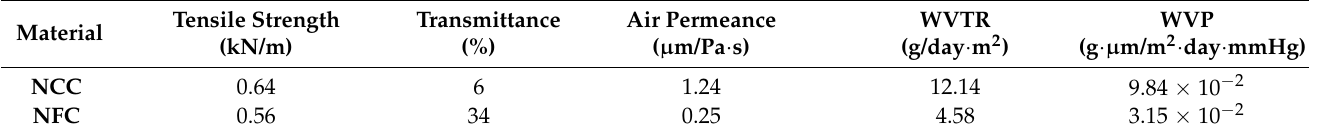
Table 4. Tensile strength, transparency, air permeance, WVTR and WVP values for NCC and